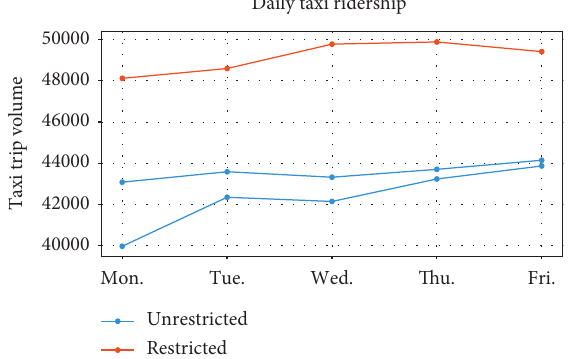
Figure 2: Daily taxi ridership in 10 consecutive